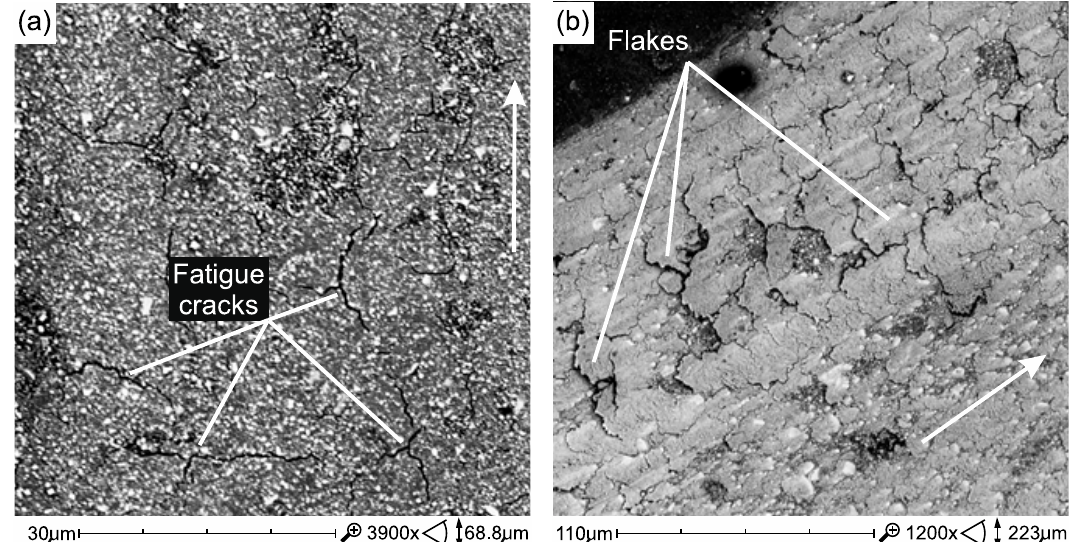
Figure 9. Wear scar of Ex-mhyb(P)—after 10 × 10 3 TC ( a ), Wear products in the form of flakes, they are symptoms of fatigue wear Z550 after 10 × 10 3 TC ( b ). Direction of sliding marked by an arrow.